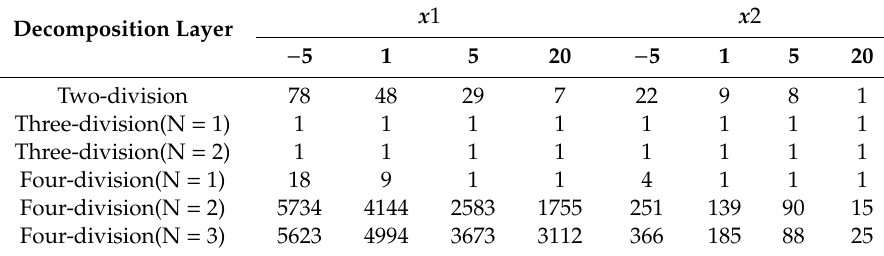
Table 3. The optimal decomposition layers of di ff erent noise reduction